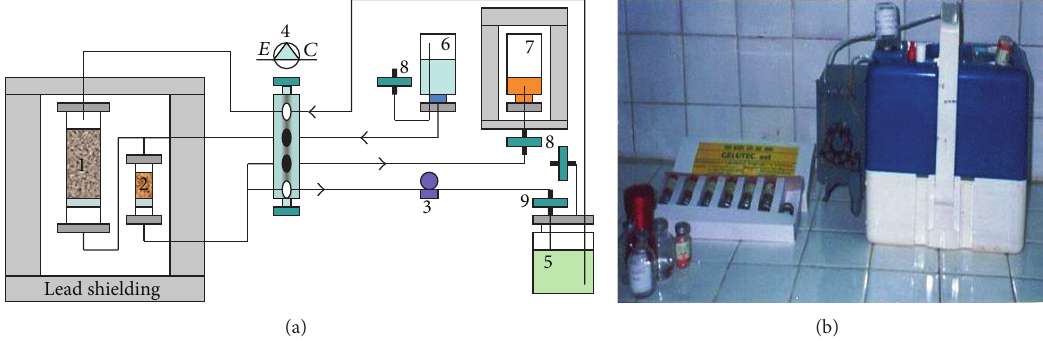
Figure 14: Integrated 99 m Tc-generator system (RADIGIS): (a) process diagram and design; (b) photo of GELUTEC-C system used for years in Vietnam which composes of a ZrMo ( 99 Mo ) gel column coupled with a zircona/alumina column-based purification/concentration unit: 1: gel column; 2: zircona/alumina column; 3: peristaltic pump; 4: selector valve; 5: circulating eluent container (water containing 0.005% NaCl); 6: saline vial; 7: final 99 m Tc solution; 8: Milipore filter; 9: coarse filter. (Specifications: Semi-automated operation based on the circulating elution with an eluent of redistilled water containing 0.005% NaCl; Processing time 20 min; Final 99 m Tc solution of 100–200 mCi/mL concentration depending on the activity of 99 Mo-loading) [57, 103].